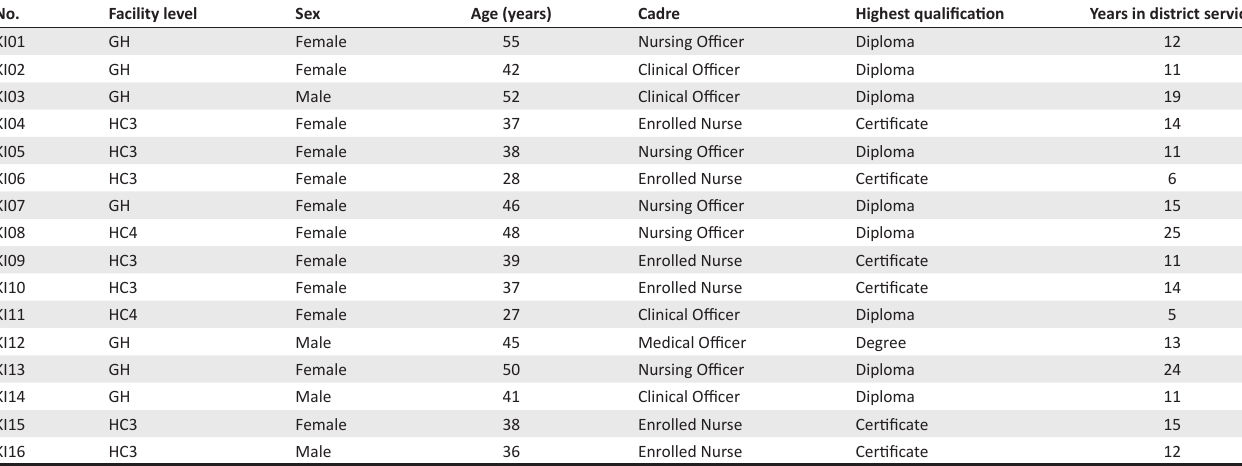
TABLE 2: Participants details of key informant interviews. No. Facility